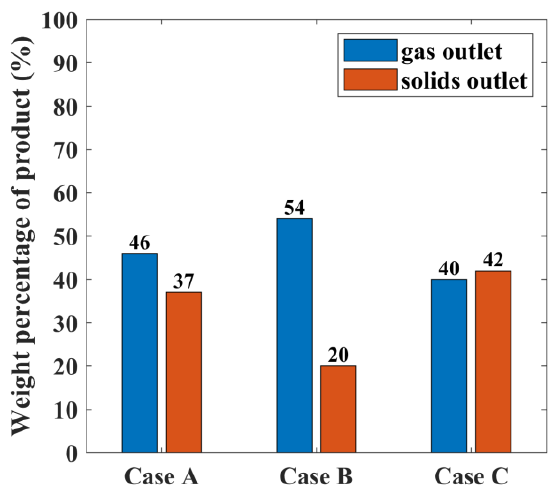
Figure 9. Comparison of weight percentage (%) of product recovered at the outlets for cases